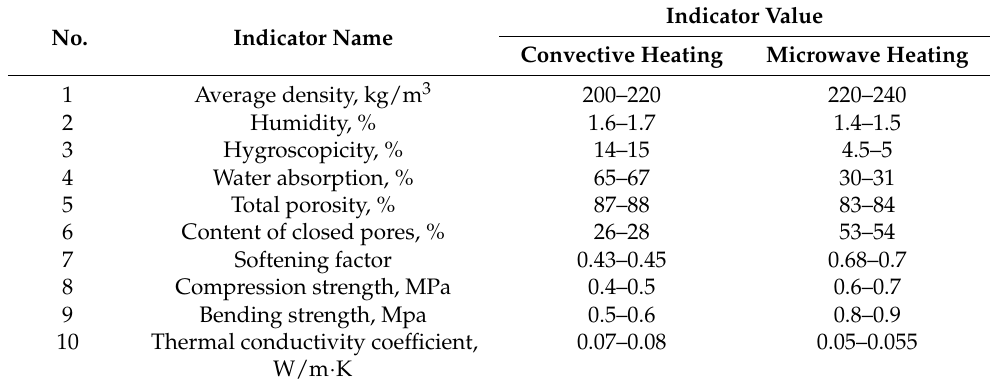
Table 1. Properties of composite thermal insulation materials obtained by microwave and convec- tive